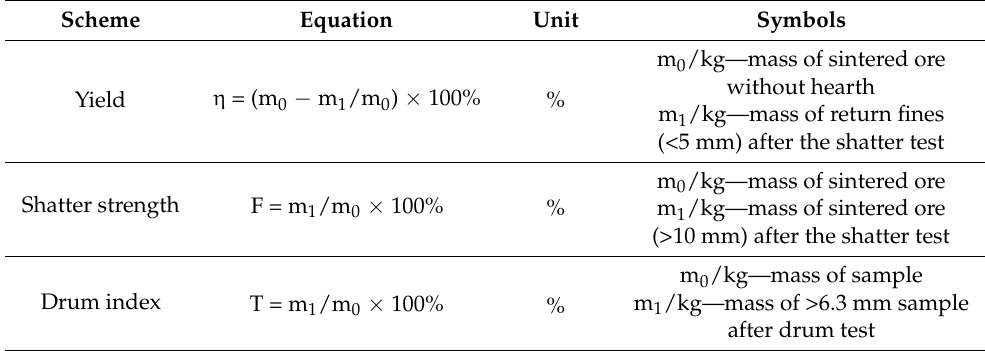
Table 6. Calculation equations for yield and qualities index of sintered